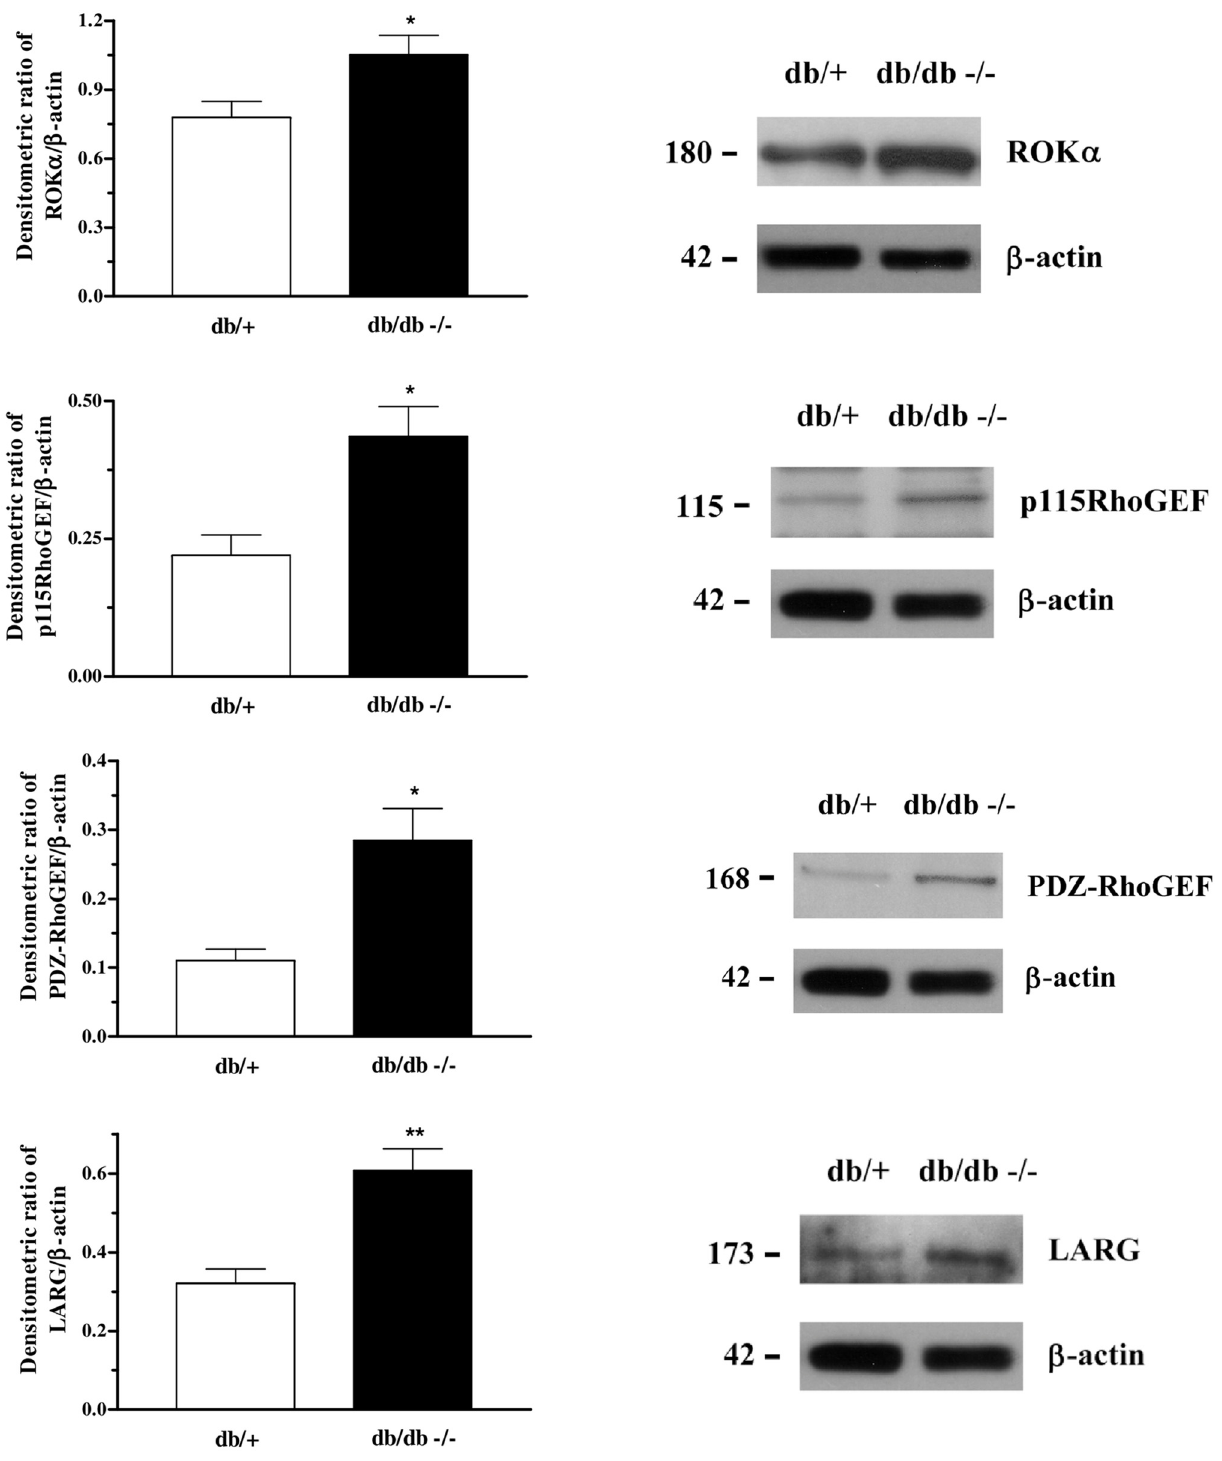
Fig 2. Increased protein expression of Rho-kinase α and RhoGEFs subunits p115RhoGEF, PDZ-RhoGEF and LARG in the corpora cavernosa of db/db mice. Data represents the mean ± S.E.M. of 4 – 6 experiments per group. * P < 0.05 and ** P < 0.01, compared to db/+